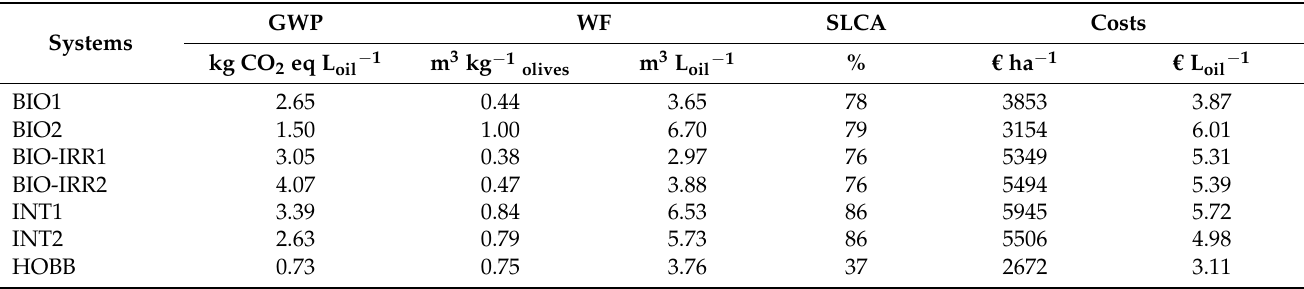
Table 10. Final results of the analyzed